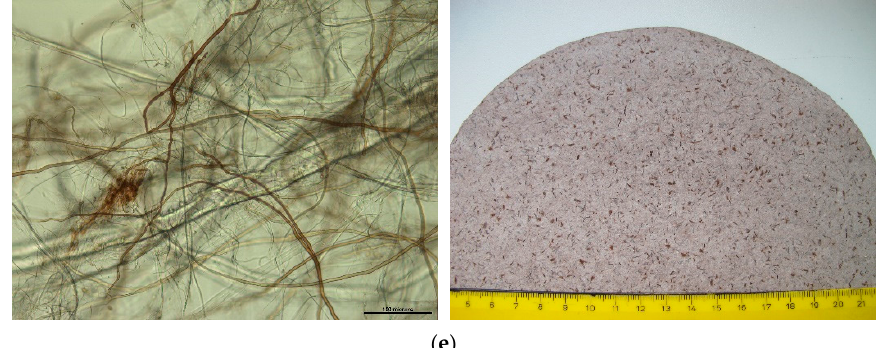
Figure 2. Microstructure (left column) and macrostructure (right column) of mycocel biopolymer compositions made of Kraft fibers (KF), hemp fibers (HF), and fungal fibers (FF): ( a ) KF FF (Ff); ( b ) KF FF (Ga); ( c ) KF FF (Tv); ( d ) KF FF (Ab); ( e ) KF HF FF (Ga). Microimages show flat hemp and softwood fibers (10–30 µ m) ( a – e ) and narrow fungal fibers (2–7 µ m) of polypores ( a – c , e ) and